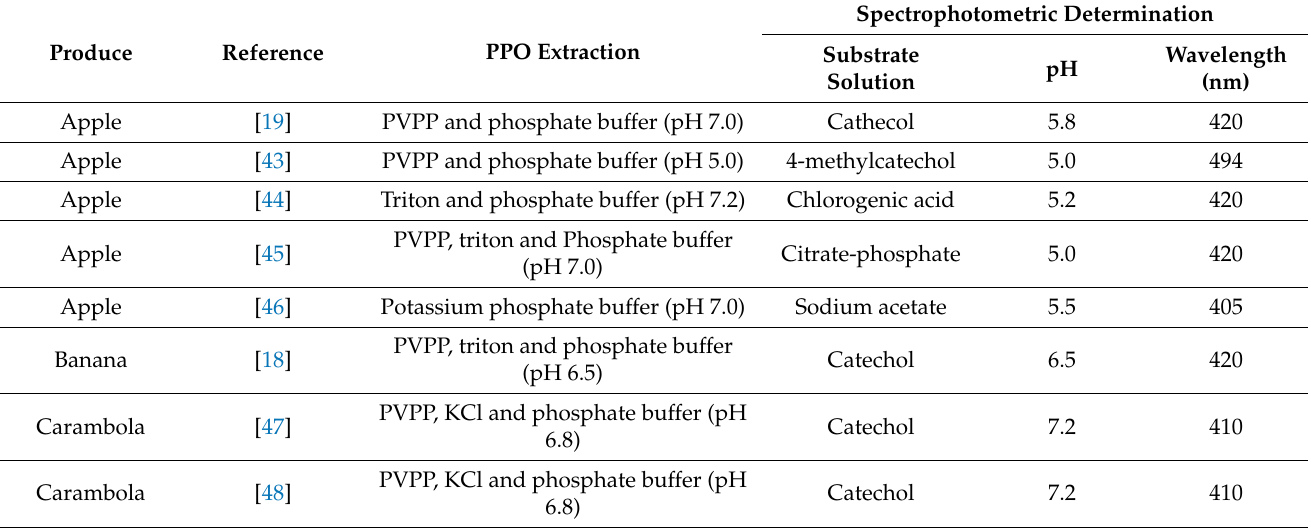
Table 2. Different conditions for PPO activity determination in some fresh-cut